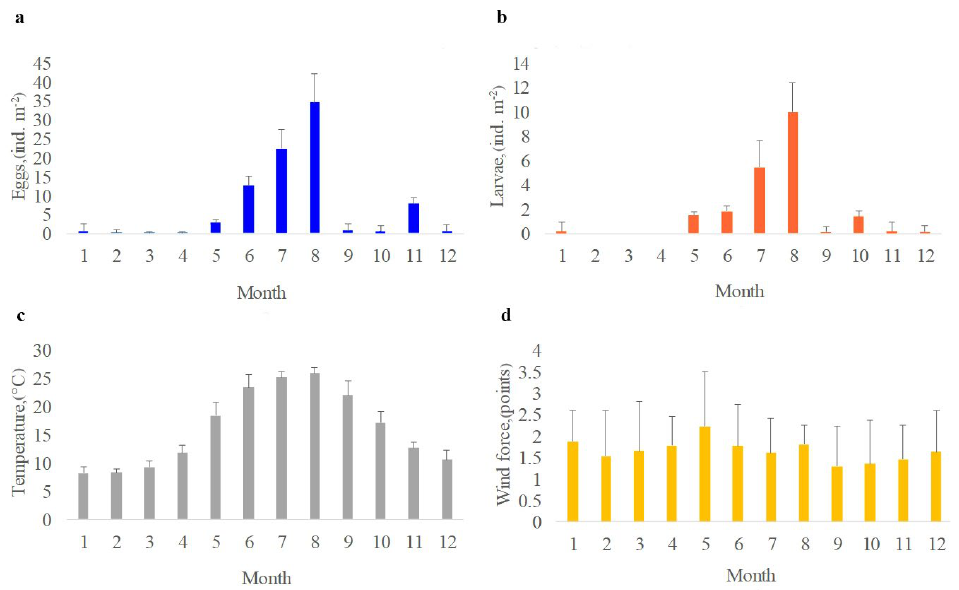
Figure 2. Intra-annual variability of the average values for the number of eggs ( a ), larvae ( b ), water temperature ( c ), the strength of the dominant north wind ( d ) with standard deviations in Sevastopol Bay in 2012–2021.